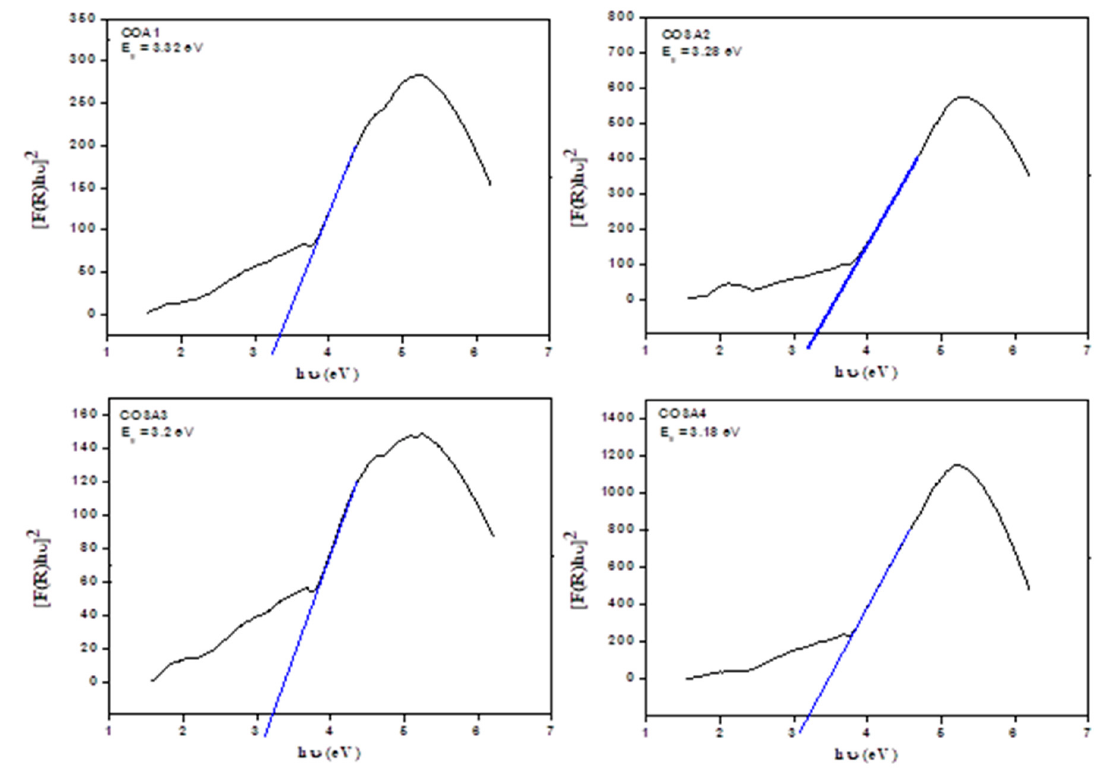
Figure 5. ( F ( R ) h ν ) 2 versus the band gap of Co 1 − x Sr x Al 2 O 4 (0 ≤ x ≤ 0.5) nanoparticles.